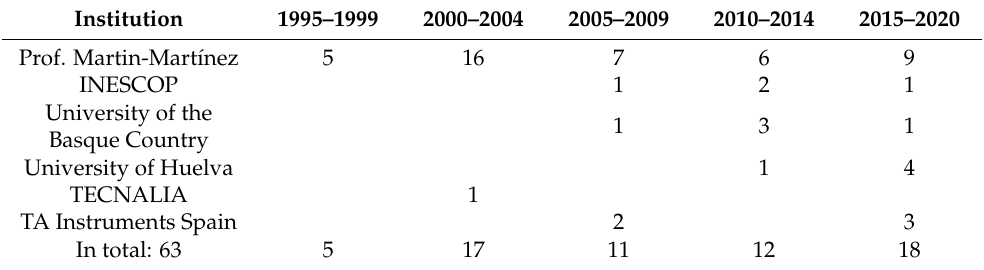
Table 4. Distribution of the papers published about adhesives in the period 1995–2020.